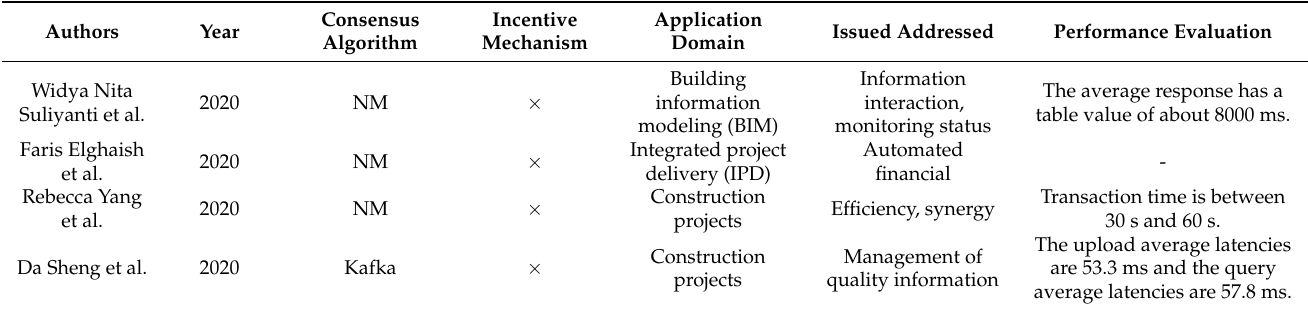
Table 8. Differences between schemes of the smart construction project (NS: mention but not specify, NM: not